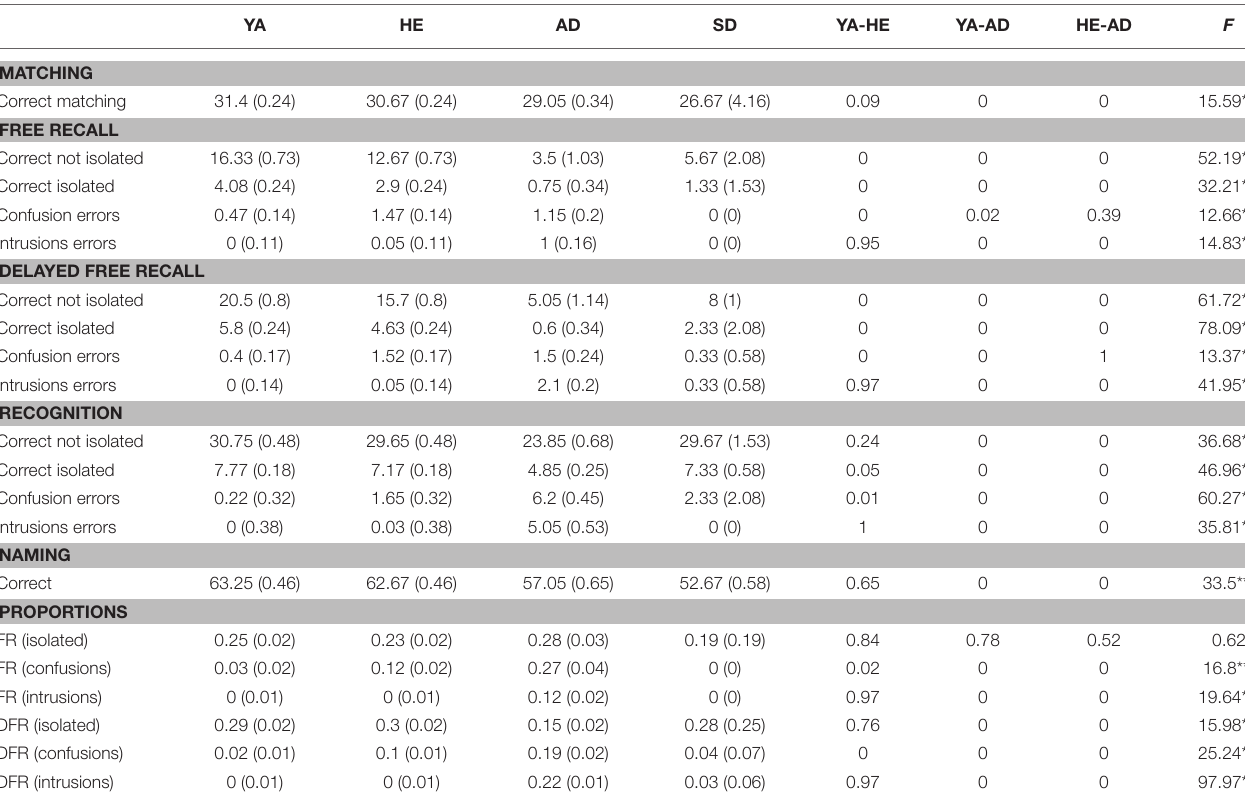
TABLE 5 | Mean scores (and standard error) for all the raw and proportion of isolated items, confusion errors and intrusion errors for the young adults (YA), healthy elderly (HE), and patient with Alzheimer’s disease (AD).